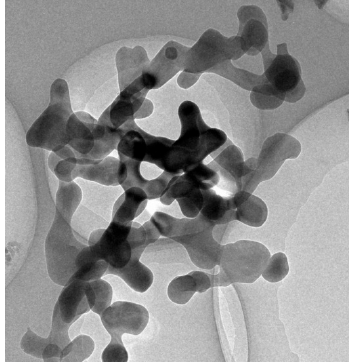
Figure 2. Scanning Electron Microscope (SEM) image of the Al 2 O 3 nanoparticle with a volume fraction of 5.92% in water.